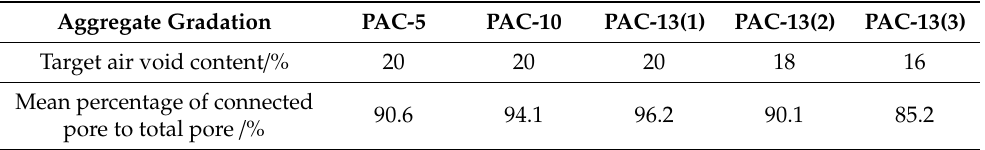
Figure 6. Percentage of connected pores to total pores along the specimen height direction. Table 3. Pore distribution properties.